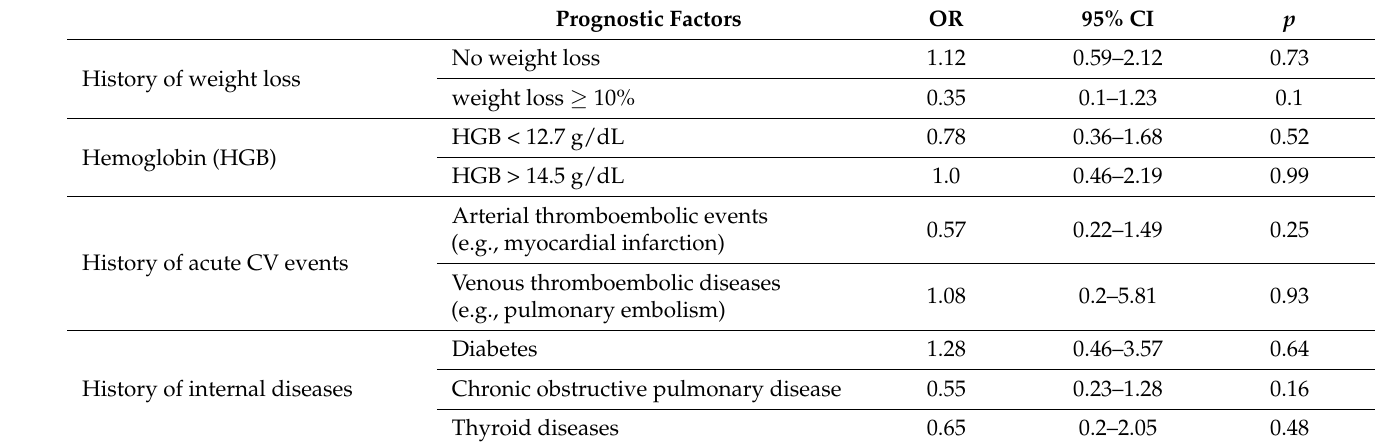
Table 3. Direct complications related to NSCLC and comorbidities as potential predictors of worsen- ing of KPS during sequential chemotherapy and radiotherapy.